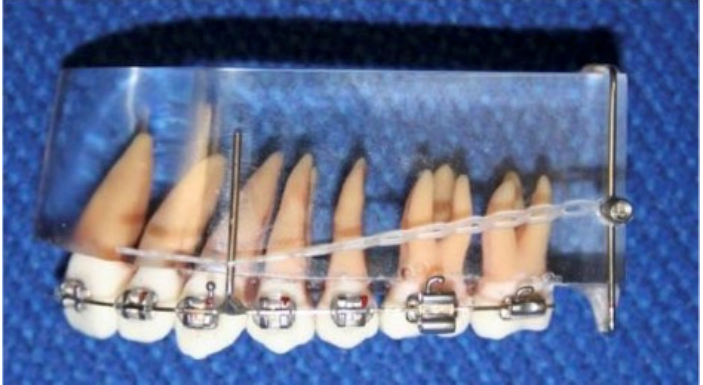
Figure 1. A photoelastic model consisting of a bracket, archwire, alveolar bone made of epoxy resin, retraction hook, posterior anchor, and elastic for applying retraction force.